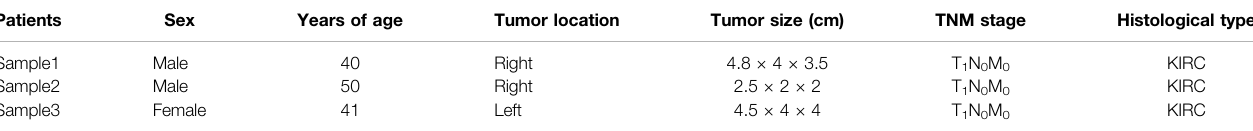
TABLE 4 | The characteristics of patients for RT-qPCR. Patients